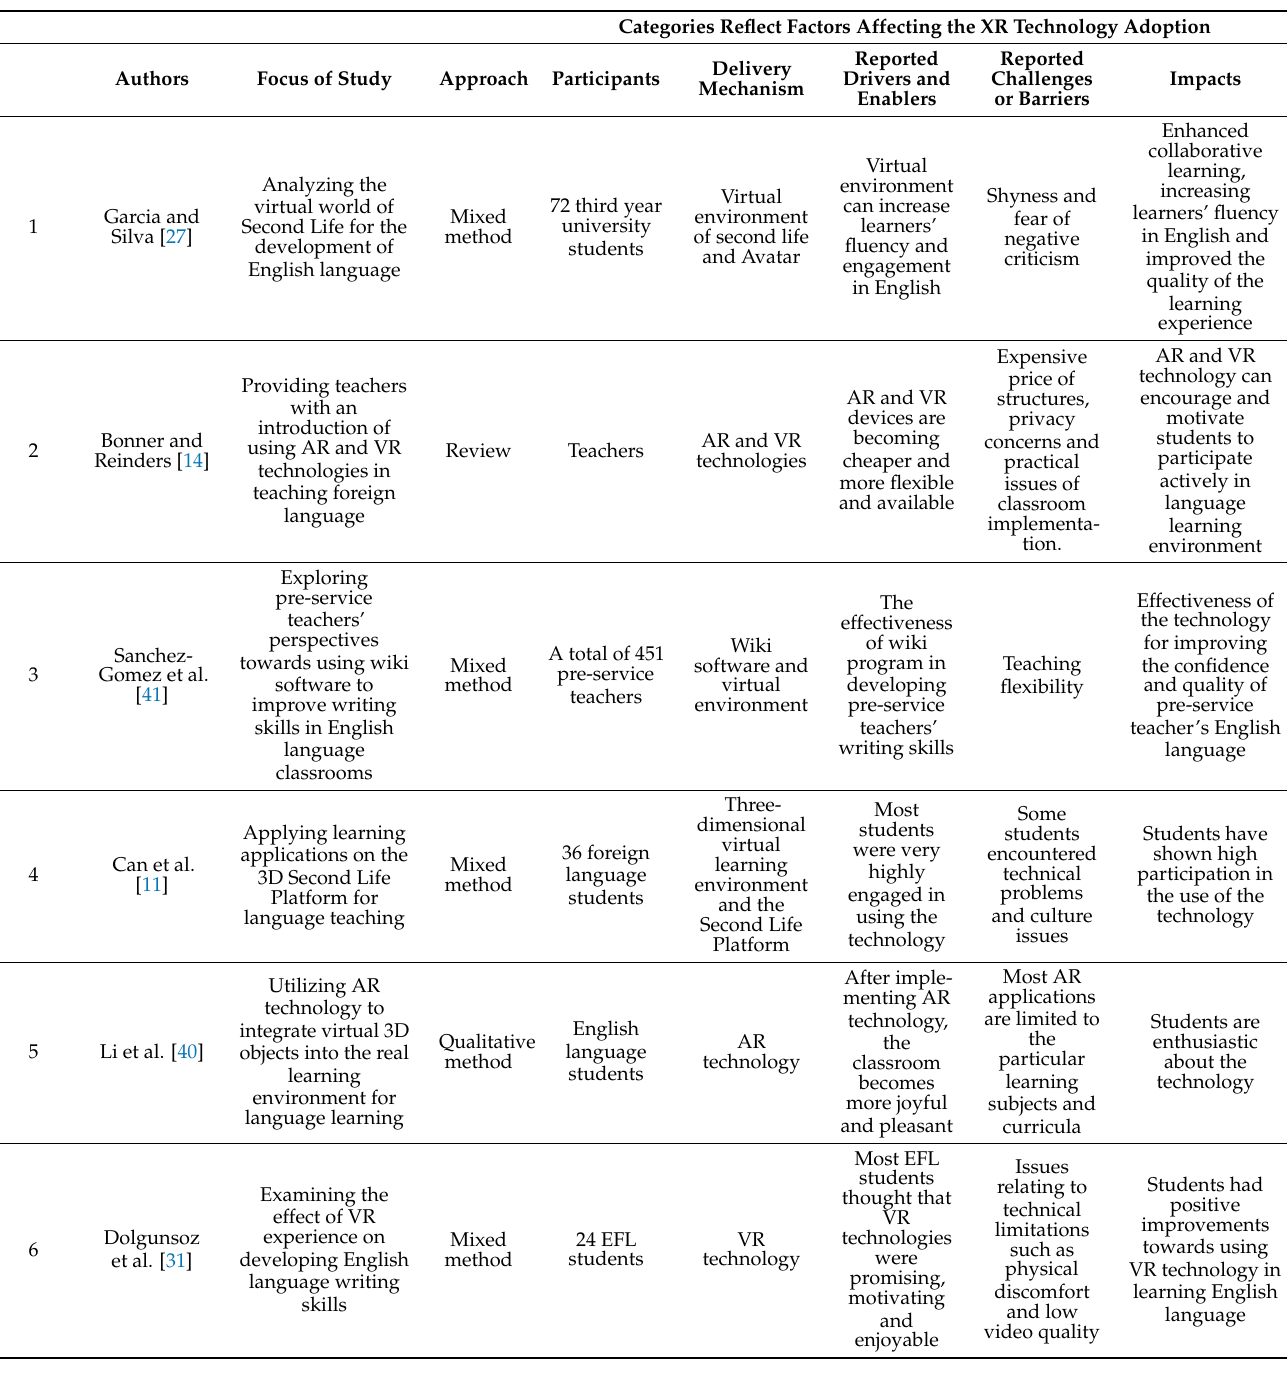
Table 1. Study characteristics and summary of the factors associated with XR